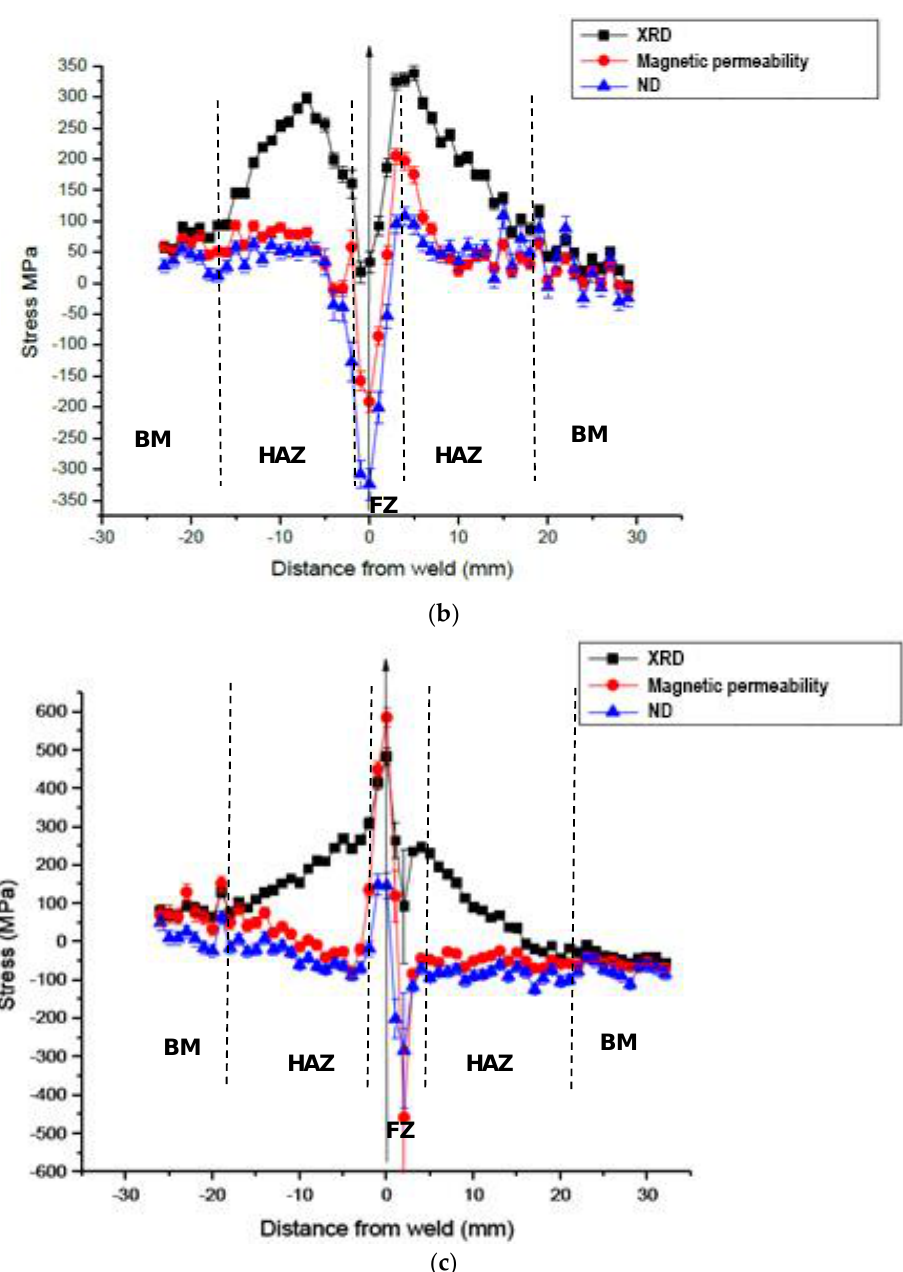
Figure 4. Residual stress profiles using X-ray diffraction (XRD), neutron diffraction (ND) and magnetic techniques (top) and optical images (bottom) of the Gas Tungsten Arc Welding (GTAW) welded ( a ) NOES, ( b ) AISI 1008 and ( c ) AISI 4130 steel samples (WD: welding direction, RD: rolling direction).